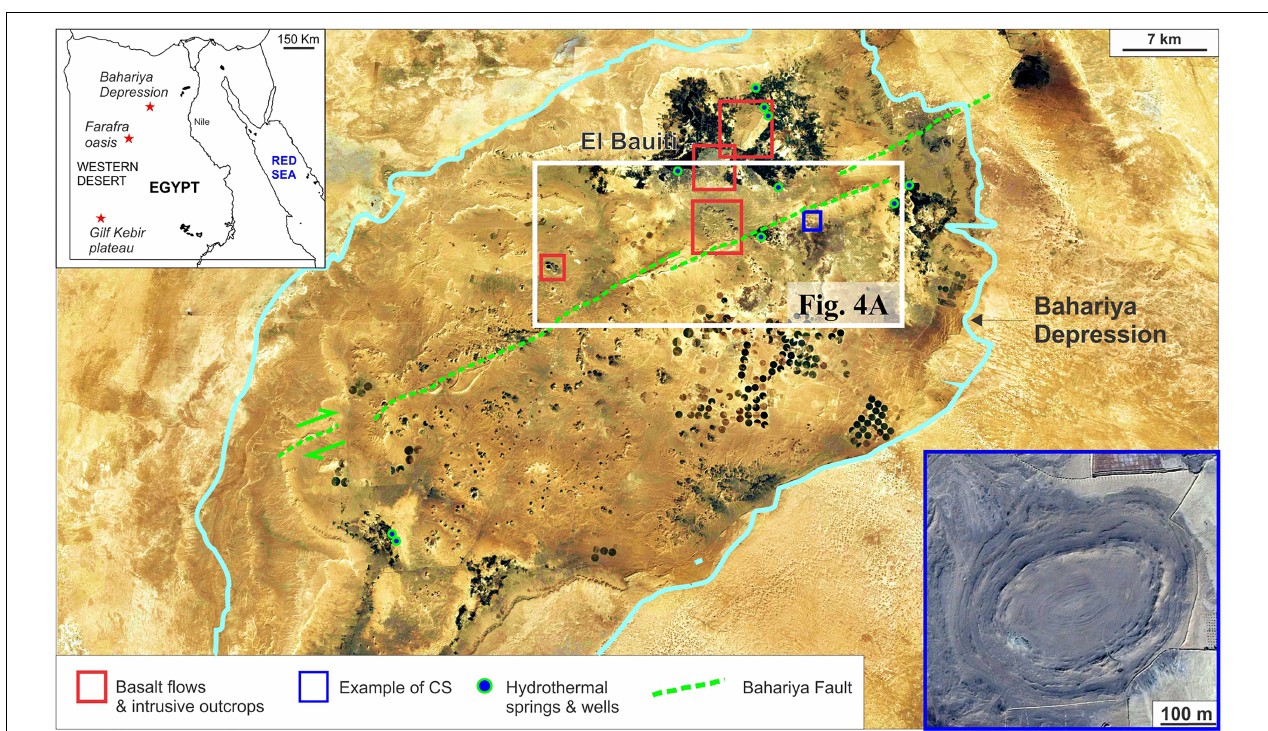
FIGURE 1 | Google Earth satellite image of the Bahariya Depression (framed in light blue) indicating the main features in the area and the water wells studied by Sciarra et al. (2017). Top left inset map: Egypt and the Western desert. Bottom right inset: example of one of the many concentric circular structures.